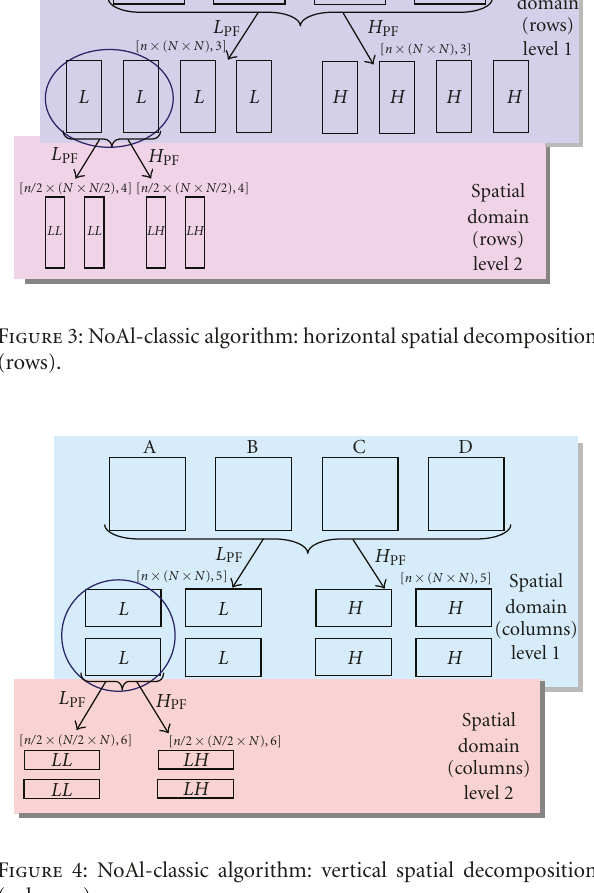
Figure 4: NoAl-classic algorithm: vertical spatial decomposition